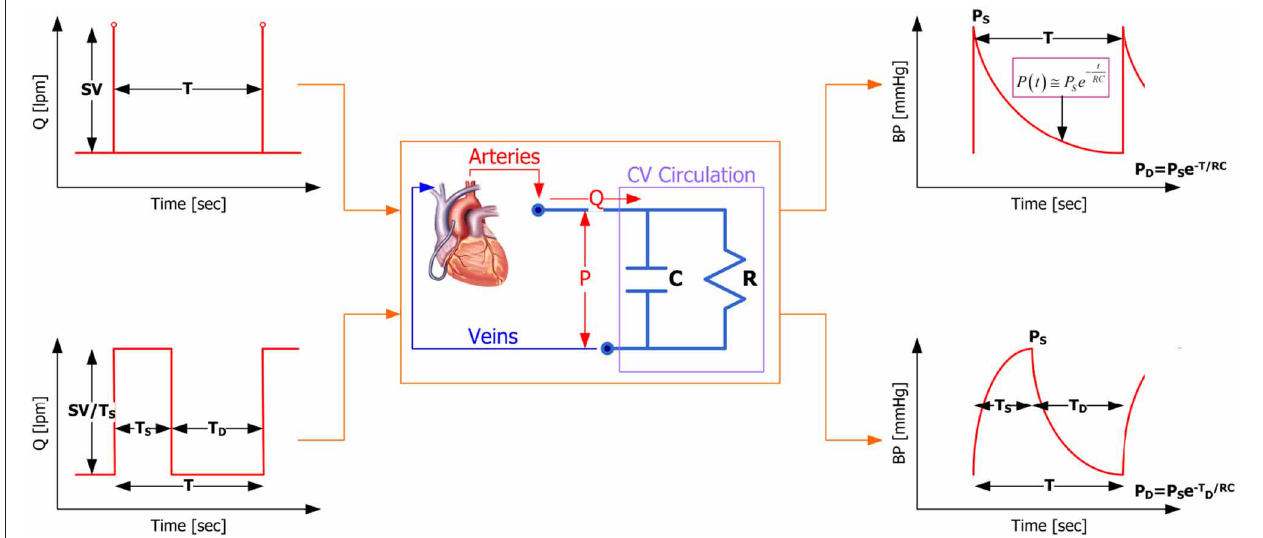
FIGURE 1 | Standard versus proposed windkessel-model-basedCVS model characterization